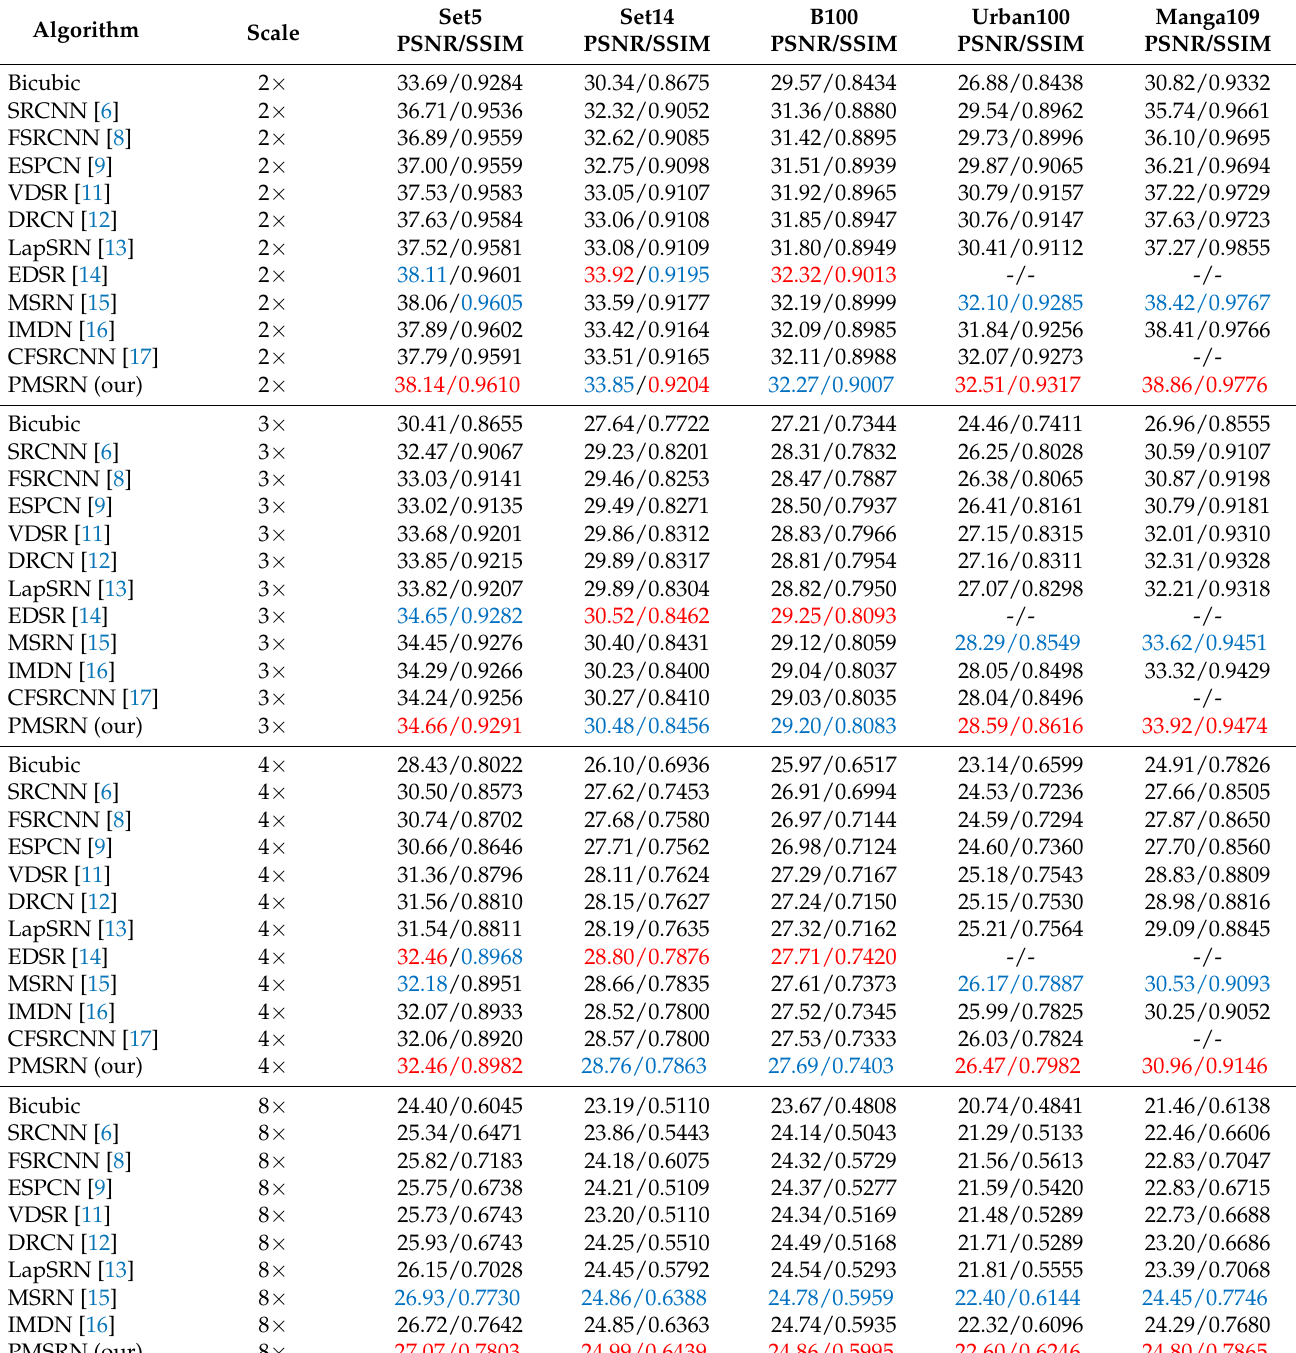
Table 3. Quantitative comparison with state-of-the-art methods. The numbers in red and blue represent optimal and suboptimal values,